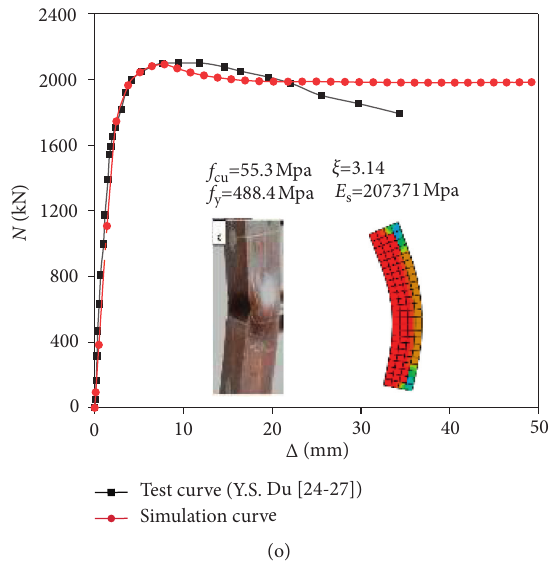
Figure 4: Comparisons for N - Δ curves between simulation and test results. (a) GZ-1. (b) GZ-2. (c) GZ-3. (d) GZ-4. (e) SC40-150-0.2. (f) SC40-180-0.2. (g) SC40-200-0.2. (h) SC50-150-0.2. (i) SC50-180-0.2. (j) SC50-200-0.2. (k) SC40-150-0.4. (l) SC40-180-0.4. (m) SC50- 150-0.4. (n) SC50-180-0.4. (o) SC50-200-0.4.